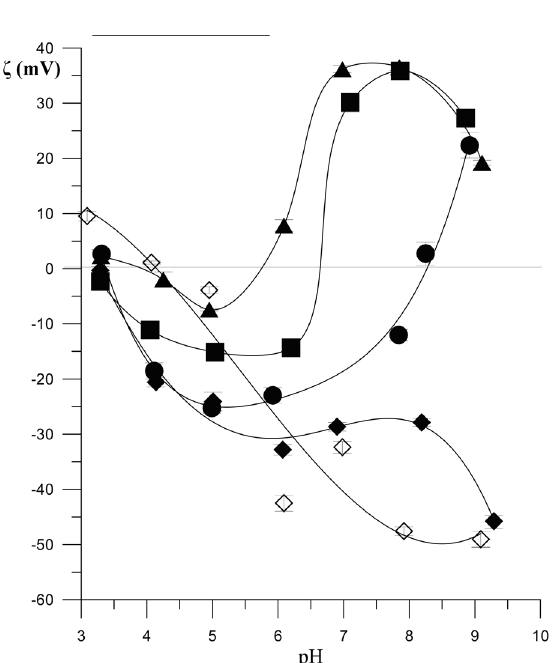
Figure 12. The potential ζ of TiO (anatase+brookite) as a 2 function of pH in the presence of Zn(II) ions. Zn (II) ions concentration: ◊ − 0, ♦ − 1×10 -6 mol L -1 , ● − 1×10 -5 mol L -1 , ■ − 1×10 -4 mol L -1 , ▲ − 1×10 -3 mol L -1 .